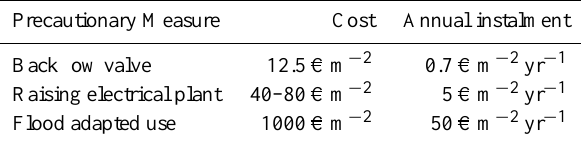
Table 4. Costs of retrofitting precautionary